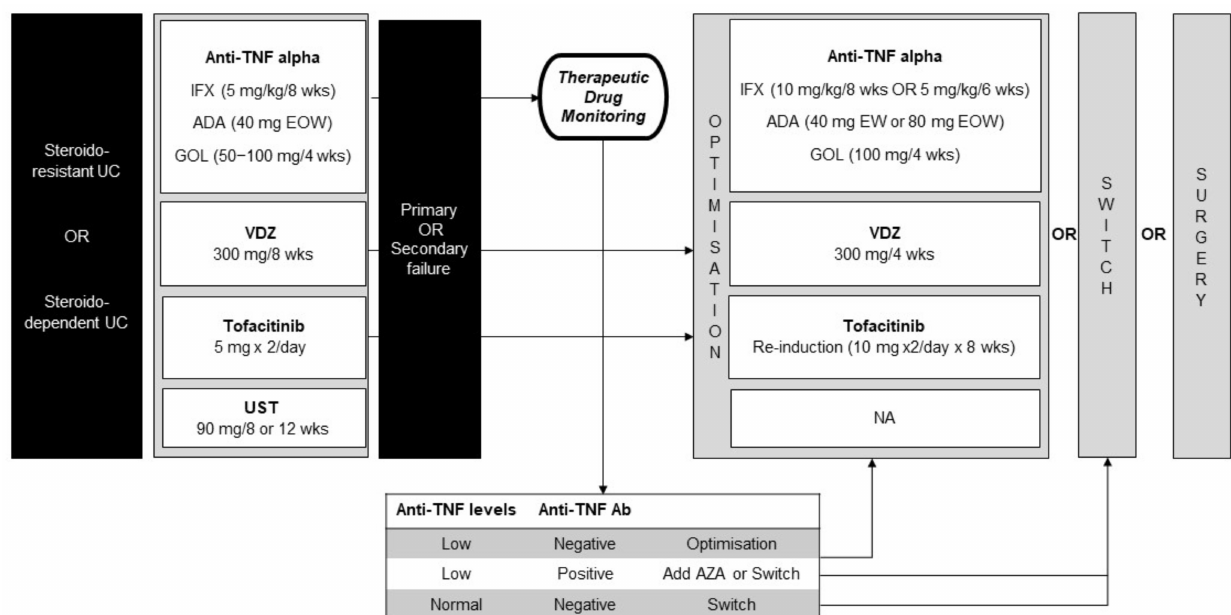
Figure 2. Biologic therapy in the maintenance of remission in UC. UC, ulcerative colitis; IFX, inflix- imab; wks, weeks; ADA, adalimumab; EOW, every other week; GOL, golimumab; VDZ, vedolizumab; UST, ustekinumab; EW, every week; Ab, antibodies; AZA,